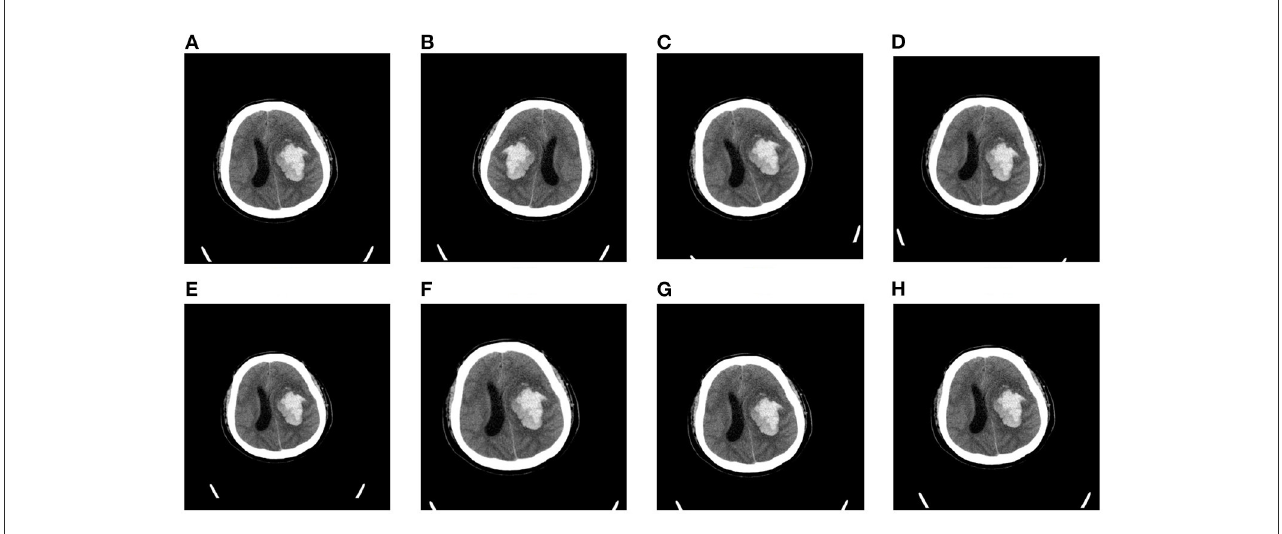
FIGURE3 Random augmentations for CT slices: (A) original slice, (B) left-right flipping, (C) rotation (10 ◦ , (D) rotation ( − 10 ◦ , (E) scaling (0.9), (F) scaling (1.1), (G) shifting (right), and (H) shifting (down).